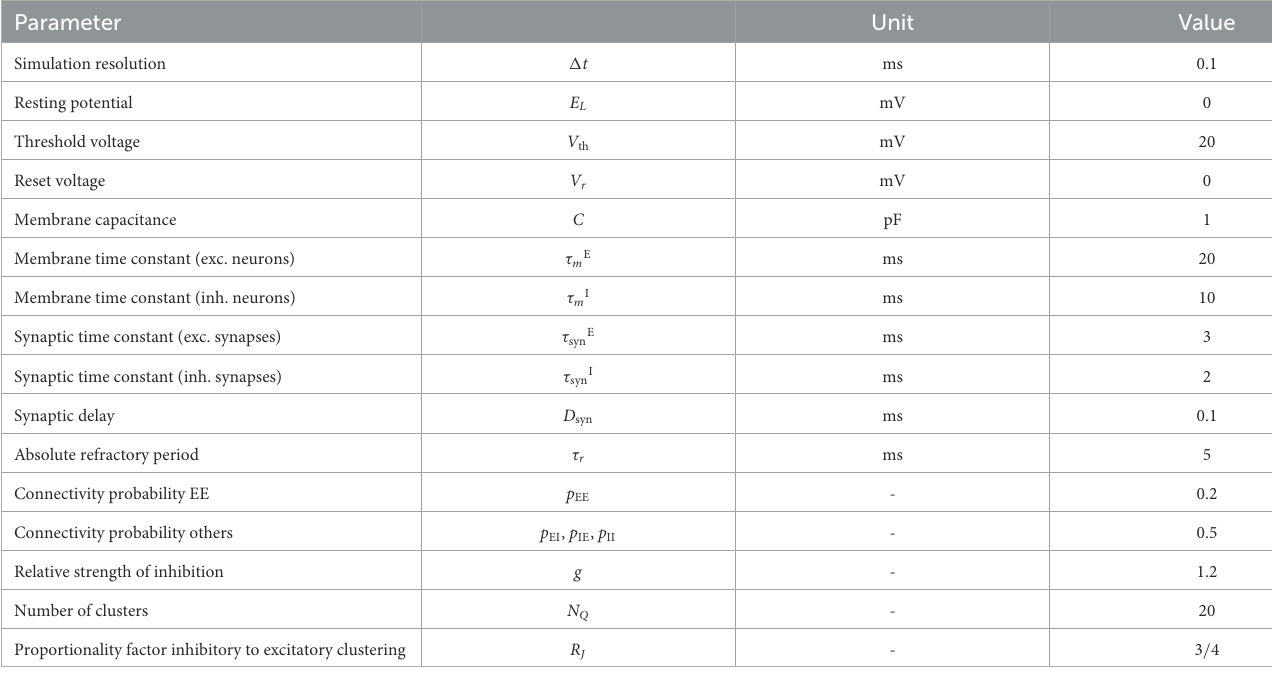
TABLE 6 Constant model parameters for all simulation modalities.